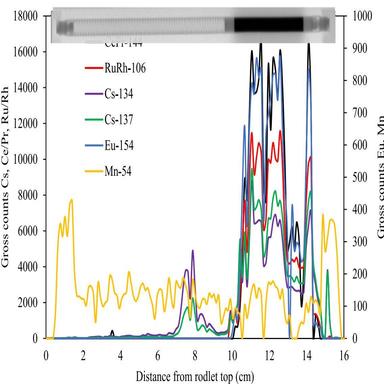
Axial gamma spectroscopy of the rodlet. At the top of the figure a high-contrast version of the neutron radiography image shown in 1B is included to show the position of the active fuel stack (in black). The small peak of Ce around 3–4 cm is believed to be anomaly in the measurement. The decrease in the signal of all of the elements between 13–14 cm is not understood by the authors.